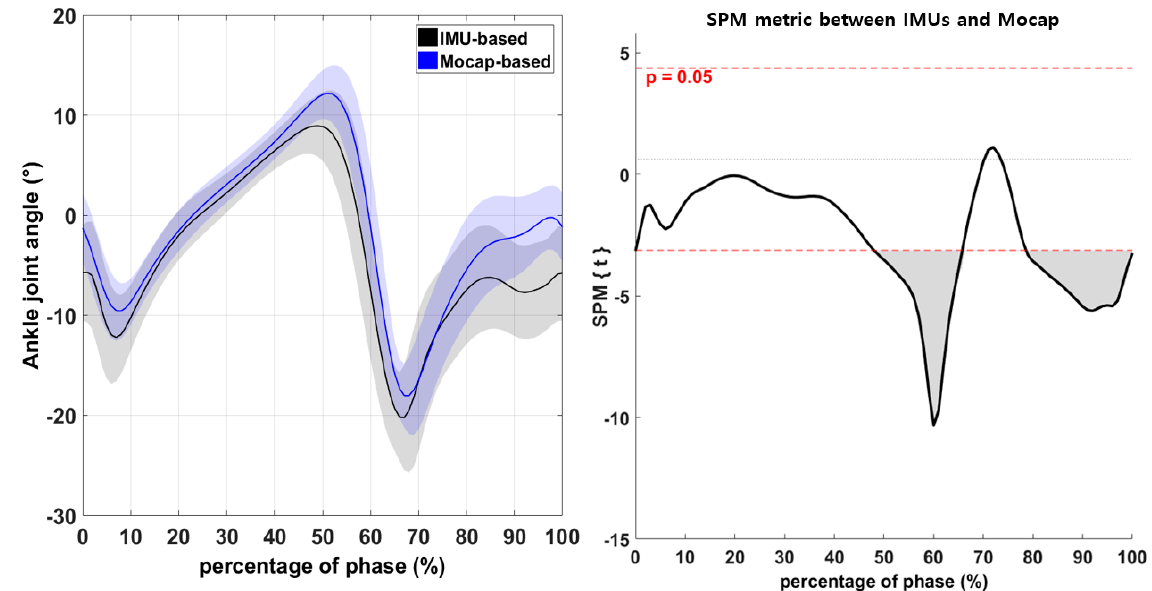
Figure 5. Comparison of the ankle-joint angle between the IMU-based and Mocap systems according to one-dimensional SPM. Horizontal dashed lines illustrate significant differences at α = 0.05, and the result is visualized as a waveform (the gray area in the figure on the right indicates significant differences).